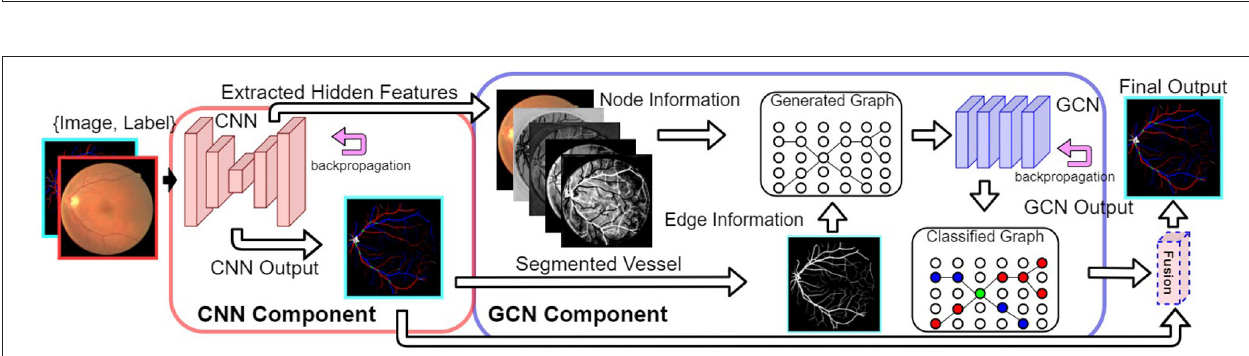
FIGURE 1 | (A) A sample fundus image. (B) Ground truth of (A) arteries, veins, vessel crossings, and uncertain vessels are marked in red, blue, green, and white, respectively. (C) Output generated by U-Net (9) on (A) (training performed by merging uncertain vessels and vessel crossings into a single class). Cyan arrows highlight vessels with multiple class assignments and orange arrows show limited vessel connectivity.